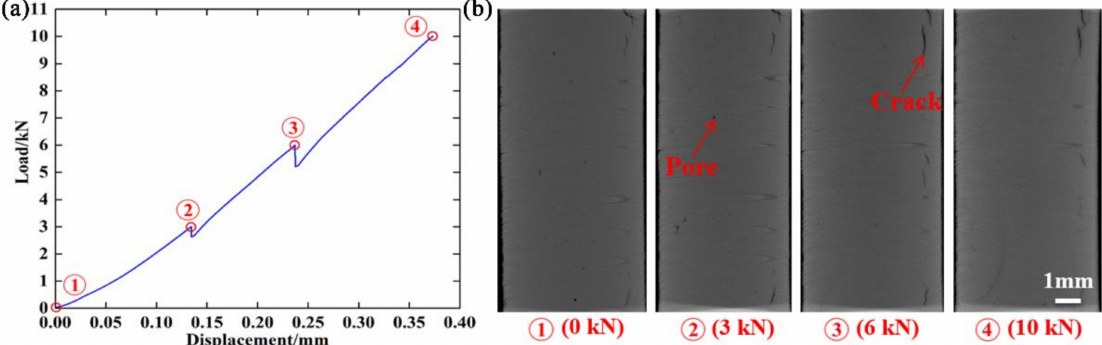
Figure 4. ( a ) Typical load–displacement curve; ( b ) two-dimensional XCT images at different com- pressive loads.